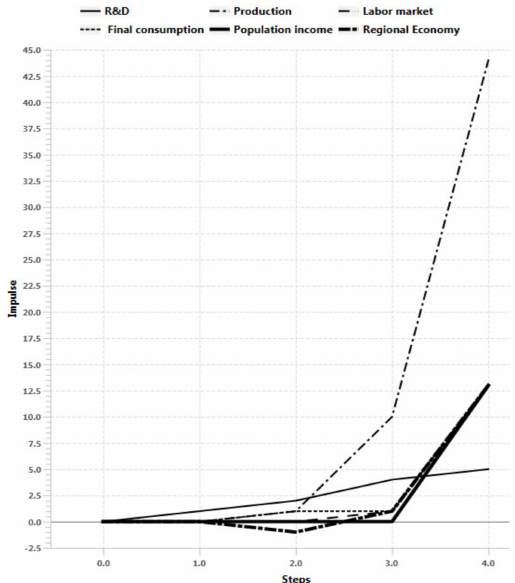
Figure 17. The graph of impulse processes at the selected vertices V1–V5, V20 Scenario "Improving the conditions of higher education and economical and political risks increasing, while federal regulatory